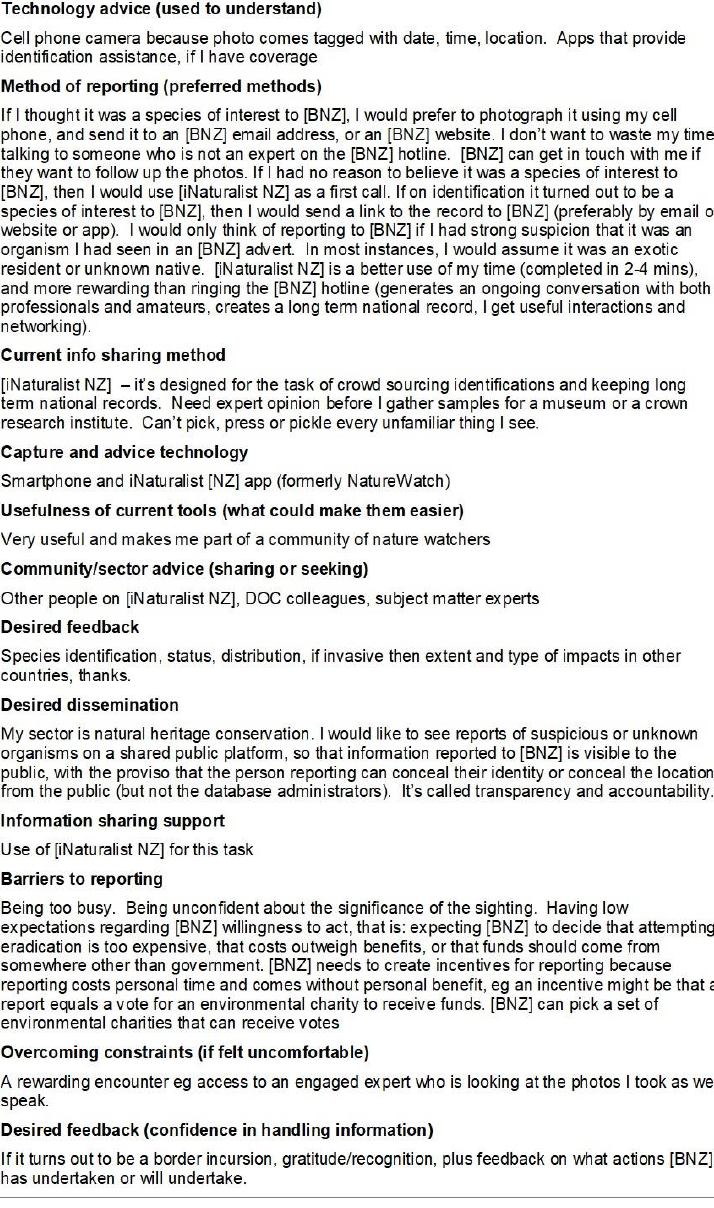
Figure A1. Sample mental model 1.